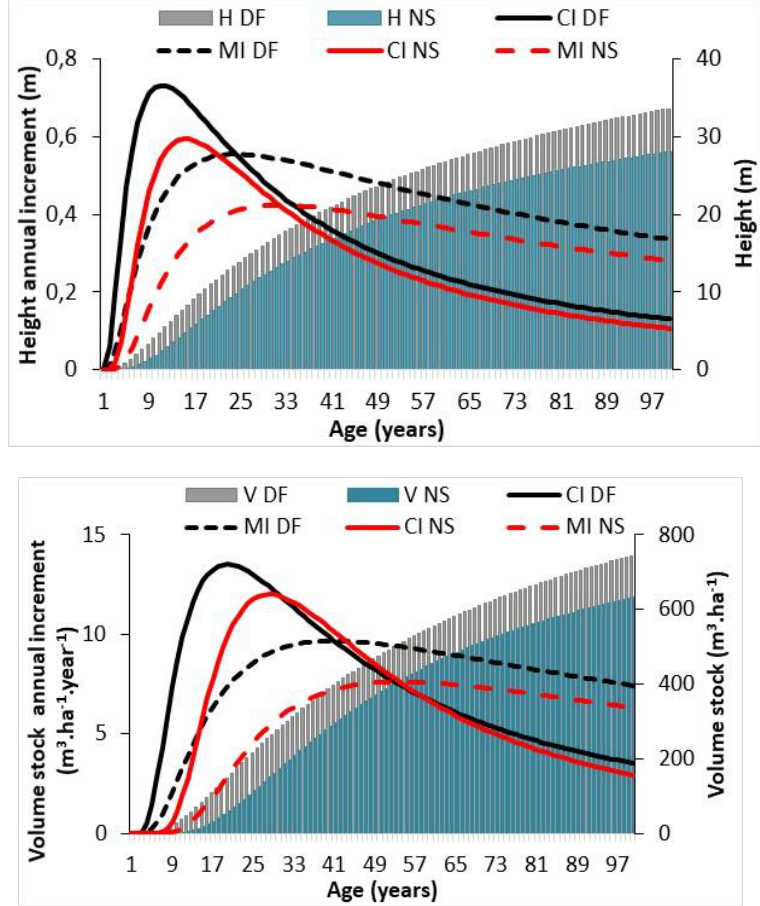
Figure 1. Courses of the current (CI) and mean increment (MI) of height (H) and volume stock (V) of Douglas fir (DF) and Norway spruce (NS) in fresh sites at UFE Kostelec nad Černými lesy, modelled by Korf’s function.